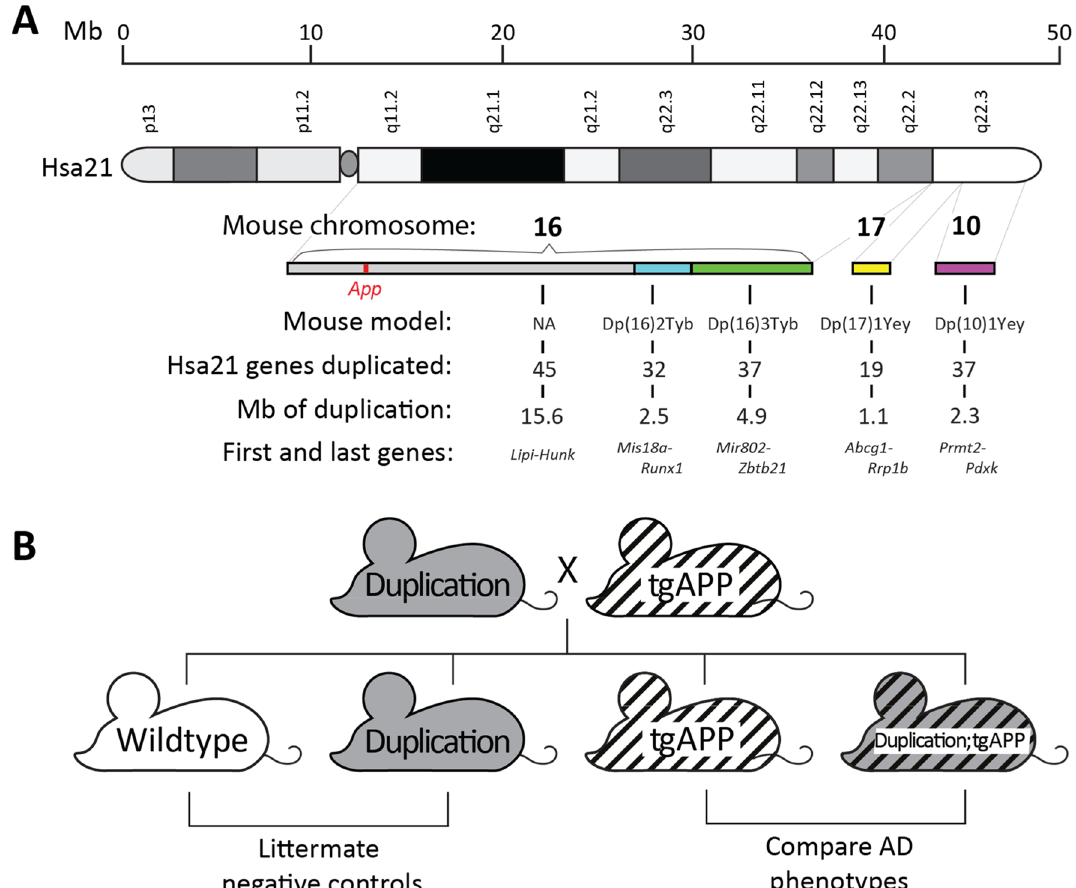
Figure 1. Mapping DS-AD associated phenotypes: analysis of progeny from crosses of J20 tgAPP with DS segmental duplication models. ( A ) Regions of Hsa21 homology on mouse chromosomes 16, 17 and 10 in the Dp(16)2Tyb, Dp(16)3Tyb, Dp(10)1Yey and Dp(17)1Yey segmental duplication models of DS. An ideogram of Hsa21 with major karyotypic bands is shown, with a megabase (Mb) scale. Below this are graphical representations of the relative sizes of Hsa21 orthologous regions in the mouse and the subregions which are segmentally duplicated in each DS mouse model used in this study. These are colour coded: Dp(16)2Tyb is light blue, Dp(16)3Tyb is green, Dp(10)1Yey is purple, and Dp(17)1Yey is yellow. “NA” refers to a subregion not modelled in this study. The number of Hsa21 orthologous genes, Mb size, first and last genes in each duplication are shown. ( B ) Schematic of the cross of the segmental duplication models of DS crossed with the J20 APP transgenic model